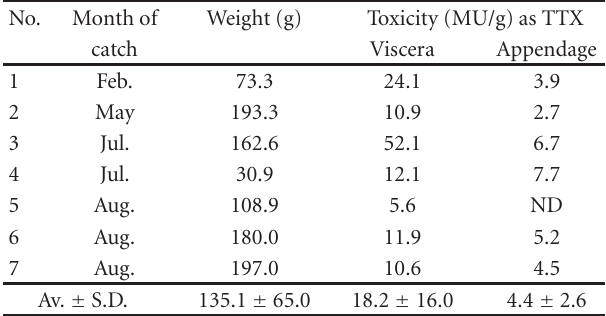
Table 1: Toxicity of Xanthid crab Demania cultripes (Alcock, 1898) from Cebu Island